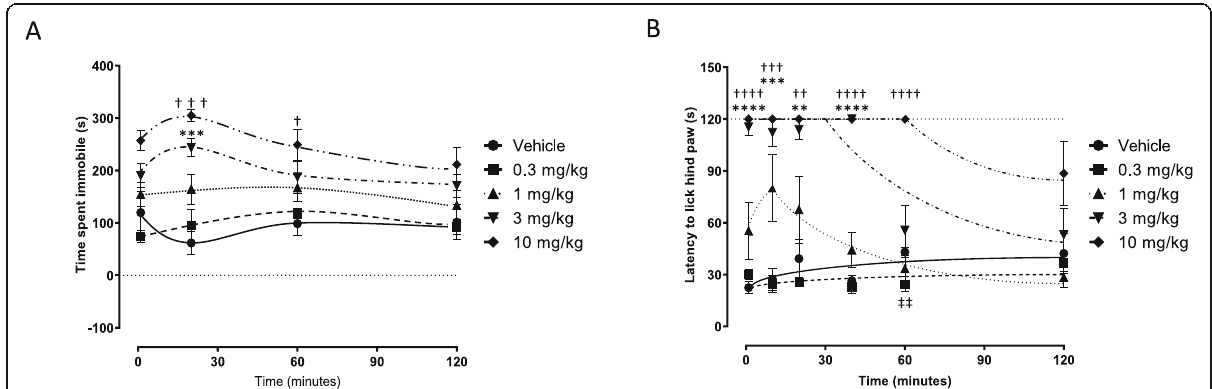
Fig. 1 A time-effect profile of pure ( ≥ 98%) Δ 9 -THC on immobility time in the tail suspension test (panel a ). Mice were intravenously dosed with control (vehicle) or 0.3, 1, 3, and 10 mg/kg pure Δ 9 -THC ( n = 5 per group, 1 animal excluded from 10 mg/kg) and immobility time evaluated for 6 min at various time points at 1, 20, 60, and 120 min. Panel b shows the time-effect curve for Δ 9 -THC in the standard hot plate assay. Mice were administered i.v. with vehicle, 0.3, 1, 3, and 10 mg/kg (n = 5 per group, 1 animal excluded from 10 mg/kg). The minimal time spent immobile at time 0 is denoted by the dotted line in panel a while the maximal latency to licking of the hind paw is 120 s and denoted by the dotted line in panel b . Data is fit using an “ eye line of best fit ” due to the lack of knowledge regarding the underlying mathematical models. Data are presented as the mean ± SEM for each treatment group. **/ †† / ‡‡ indicates P < 0.01, ***/ ††† indicates P < 0.001, ****/ †††† indicates P < 0.0001. Δ 9 -THC doses were compared to vehicle at the given time